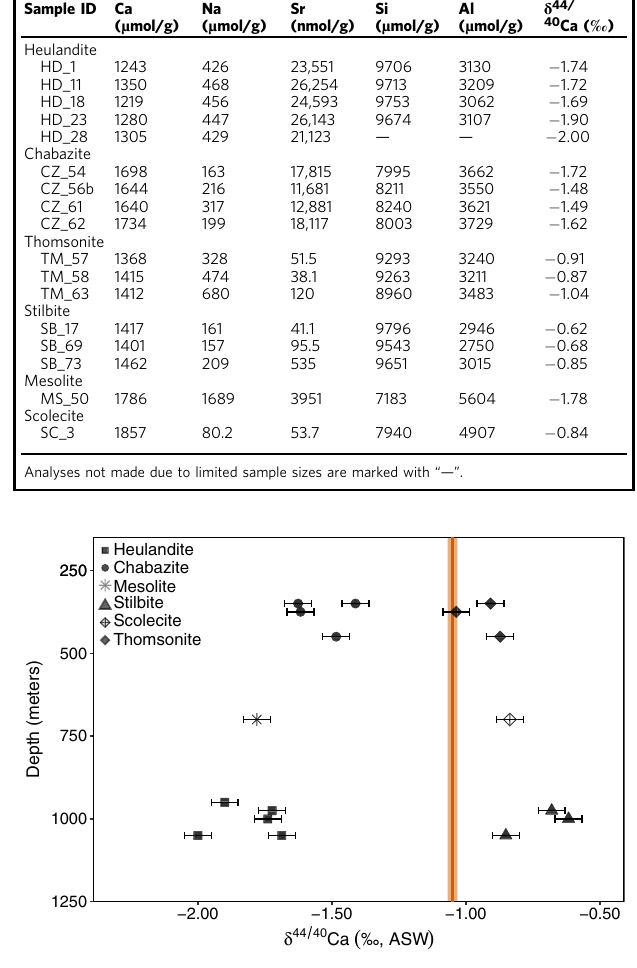
Fig. 2 Zeolite δ 44/40 Ca versus burial depth. δ 44/40 Ca of bulk zeolites versus approximate burial depth in the Berufjörður – Breiðdalur region 64 . The orange line shows the average value for all basalts analyzed here and by Jacobson et al. (2015), with the width encompassing the standard deviation ( − 1.05 ± 0.06 ‰ , 2 σ SD , n = 11). Error bars show external reproducibility (±0.05 ‰ , 2 σ SD ).